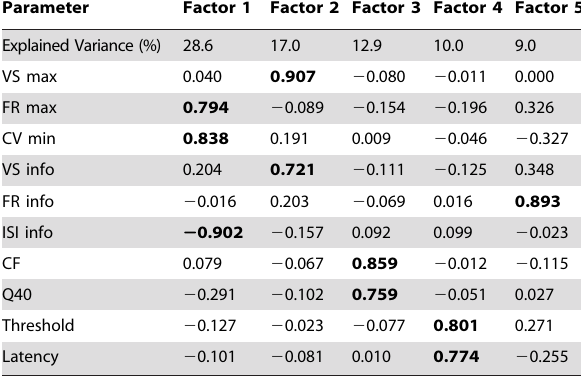
Parameter Factor 1 Factor 2 Factor 3 Factor 4 Factor 5 Explained Variance (%)